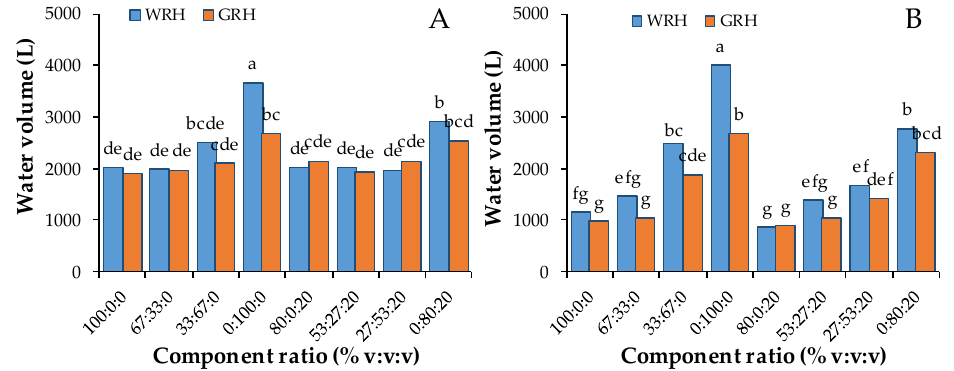
Figure 3. Interaction effects of the component ratio (P:RH:ADR % v:v:v) and RH grinding (whole rice hulls and ground rice hulls, WRH and GRH) on the volumes of irrigation water required by geranium ( A ) and rose ( B ) during cultivation in the evaluated substrates. Significant differences among treatments are indicated by different letters according to Tukey’s HSD test ( p < 0.05).